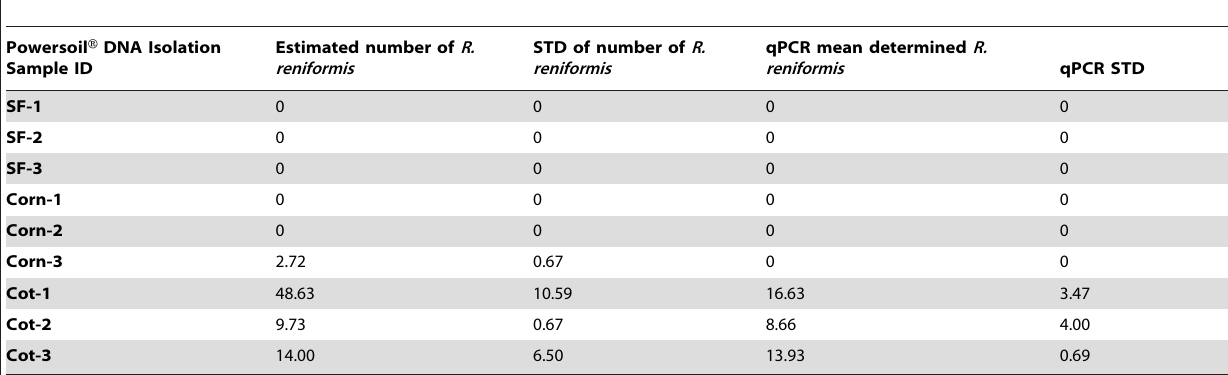
Table 5. Comparison of hand counted (estimated) and qPCR experimentally determined R. reniformis DNA extracted directly from